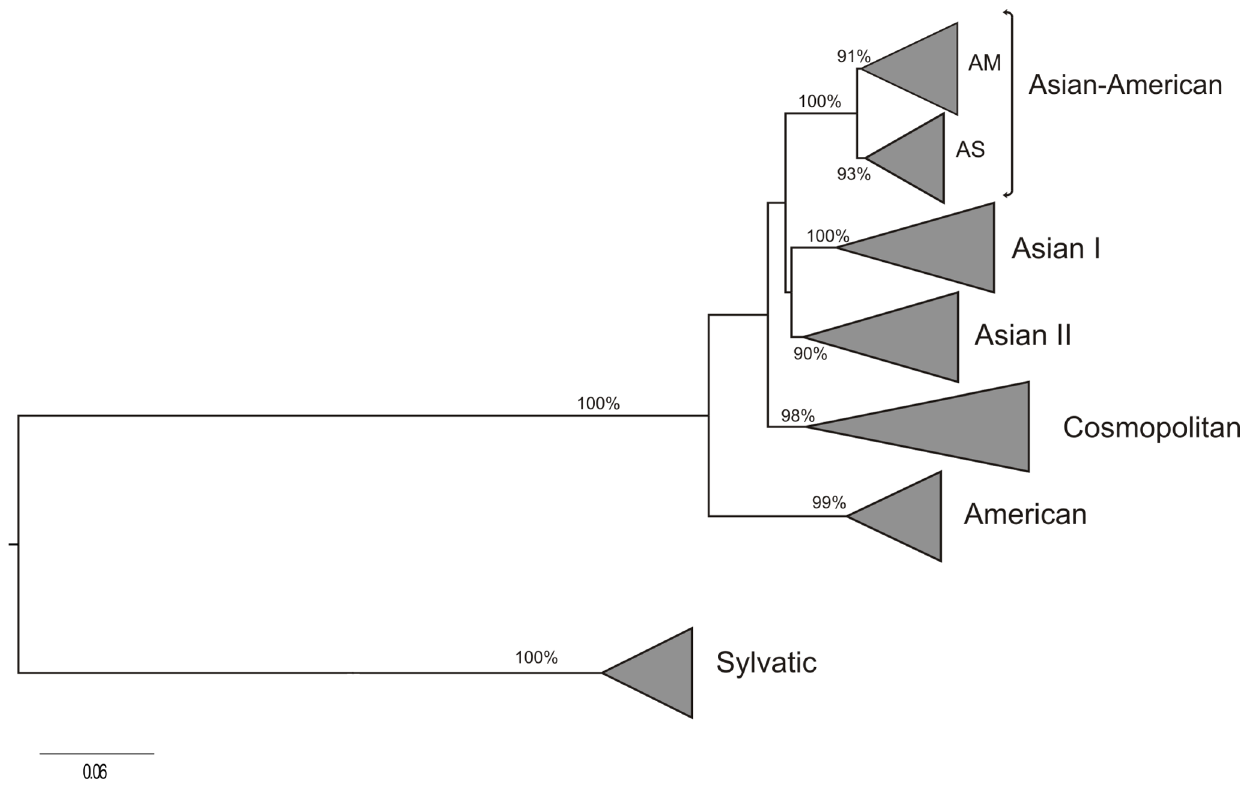
Figure 1. ML tree of 1,932 DENV-2 E gene sequences circulating globally. DENV-2 genotypes (Sylvatic, American, Asian I and II, Cosmopolitan and Asian/American) are identified. For visual clarity, strains from each genotype are shown collapsed. Only aLTR support values of major branching are shown. All horizontal branch lengths are drawn to a scale of nucleotide substitutions per site.